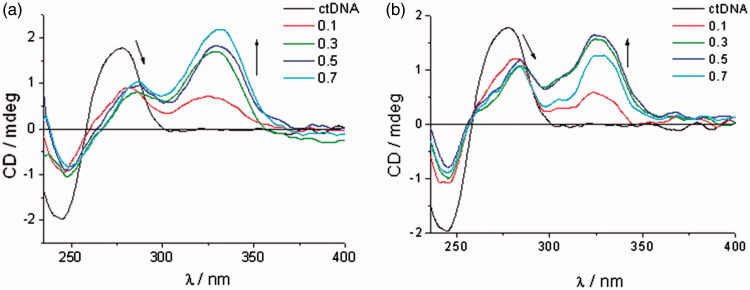
Induced CD spectra of compound 7a (a) and compound 8c (b) with ctDNA (r = 0–0.7).